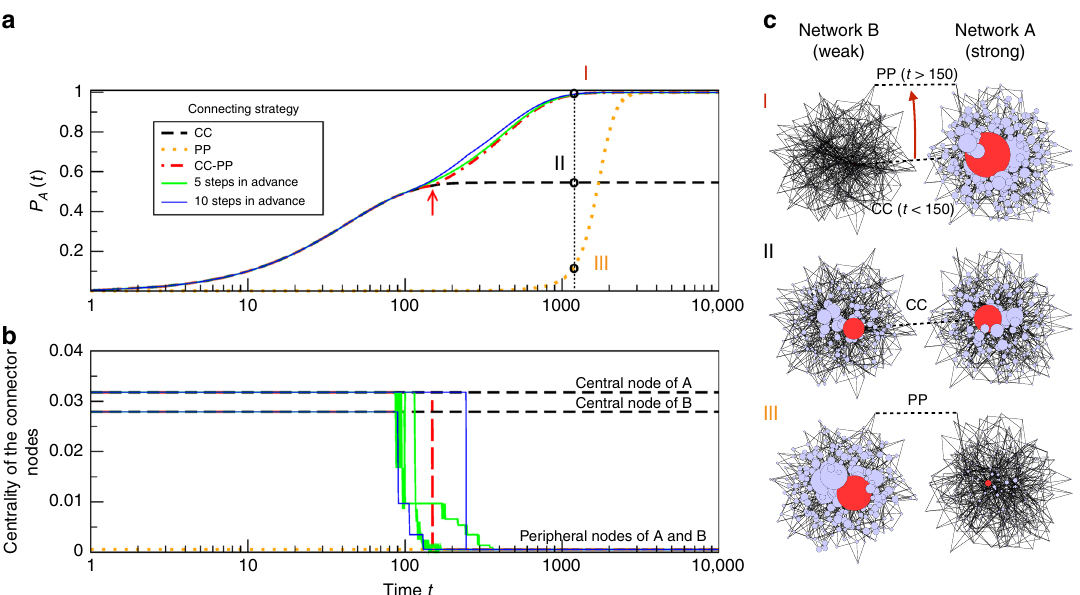
Fig. 1 Evolution of a dynamical process on two interconnected networks. They are two different Barabási-Albert (scale-free) networks 36 of N A ¼ N B ¼ 250 nodes, L A ¼ L B ¼ 736 links, λ A ; 10 : 325 and λ B ; 10 : 253. We simulate the spreading of knowledge following a model of innovation networks 18,25,29 1 ¼ 1 ¼ where all knowledge is initially placed at the weak network B . Networks are initially disconnected and then connect through a single connector link following different connection strategies. a Evolution with time of the knowledge accumulated at strong network A . The connection strategies are CC (the most central node in A is connected to the most central node in B for all times), PP (the most peripheral node in A is connected to the most peripheral node in B for all times), CC – PP (the networks swap from CC to PP strategy when the CC-asymptotic equilibrium has been reached, indicated by the red arrow at t ¼ 150) and an exhaustive method choosing the most favourable connection for A from all possible scenarios after 5 and 10 steps. b Evolution with time of the connector nodes — those that are connected to the other network — relative to the fi ve different strategies. Each node is represented by its centrality measured in networks A and B in isolation. c Plot of the knowledge of both networks at t ¼ 1200 time steps for the three different strategies indicated by the dotted line in a . The radius of the nodes is proportional to their knowledge. Networks ’ hubs are indicated in